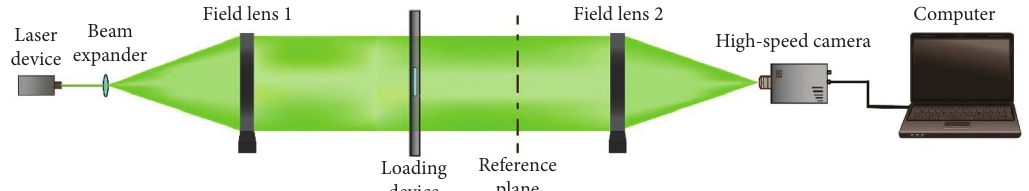
Figure 1: Dynamic caustics experiment system.